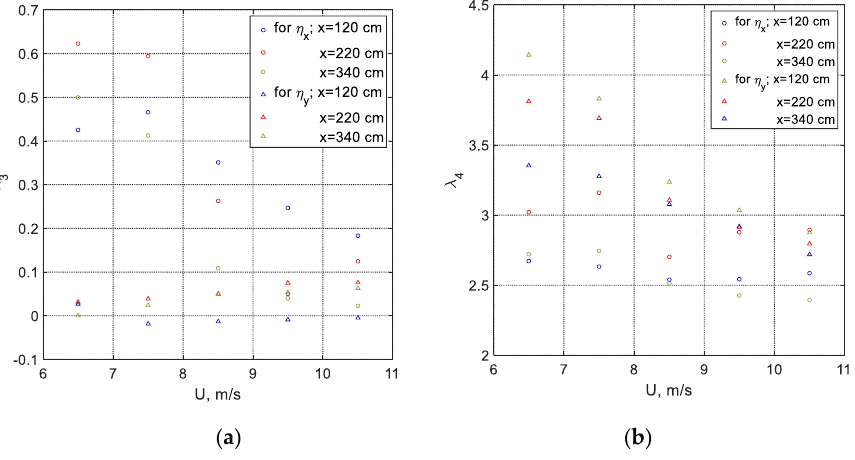
Figure 20. Higher order statistical parameters of surface slope components η x and η y : ( a ) the skewness coefficients λ 3 ; ( b ) the kurtosis coefficients λ 4 .